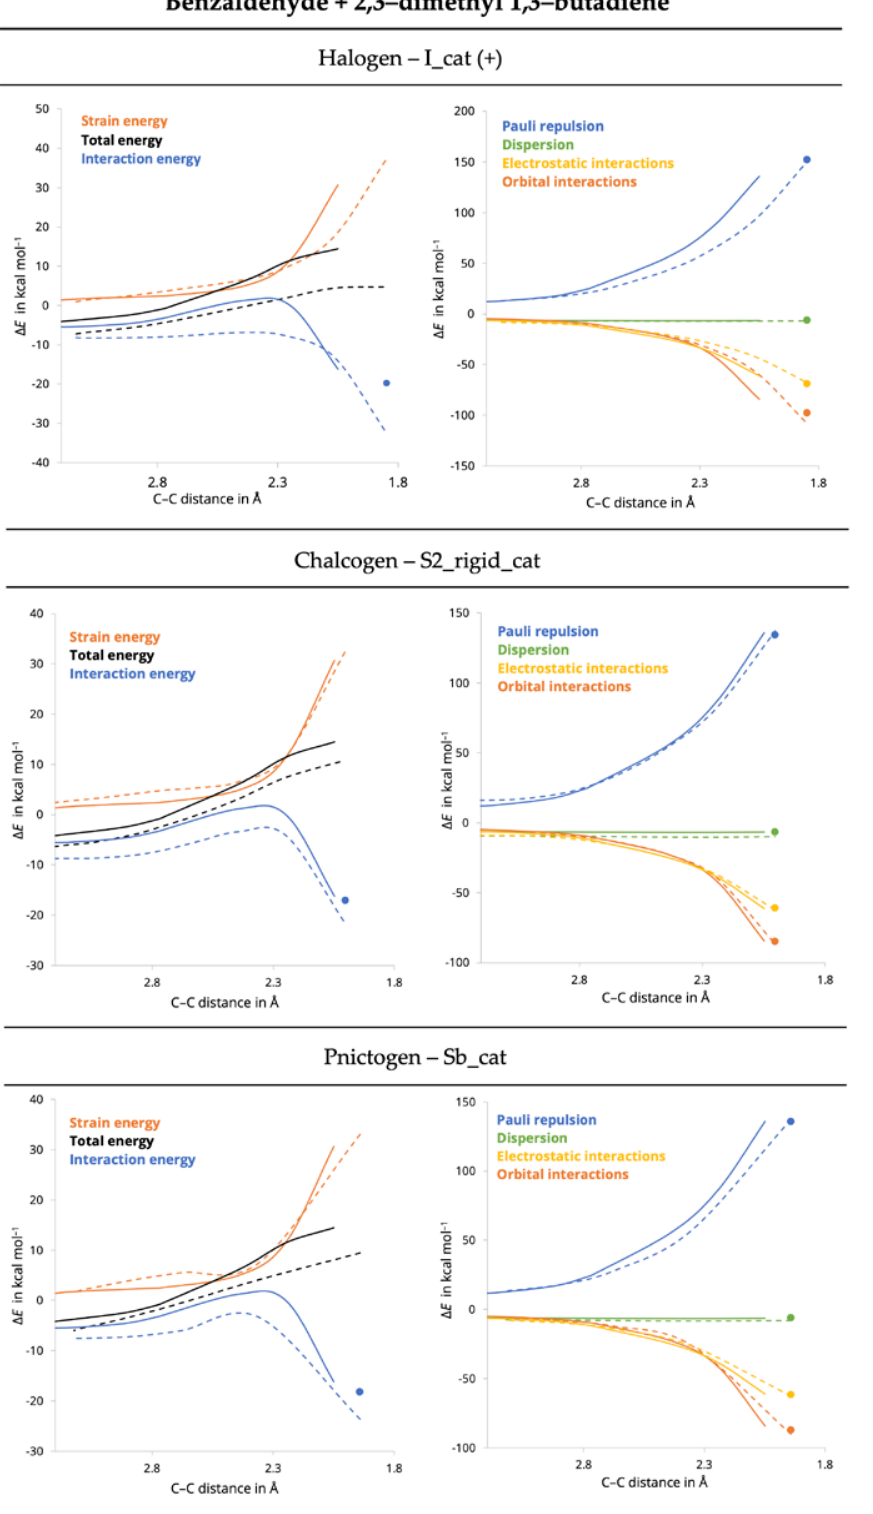
Figure 5. ASM ( left ) and EDA ( right ) analysis of the uncatalyzed and halogen-, chalcogen-, and pnictogen-bond-catalyzed reactions between benzaldehyde and 2,3-dimethyl 1,3-butadiene. The solid line represents the reaction without the catalyst, and the dashed line represents the reaction with the catalyst. The dots represent the values for the transition-state geometry of the catalyzed reaction with the catalyst deleted.